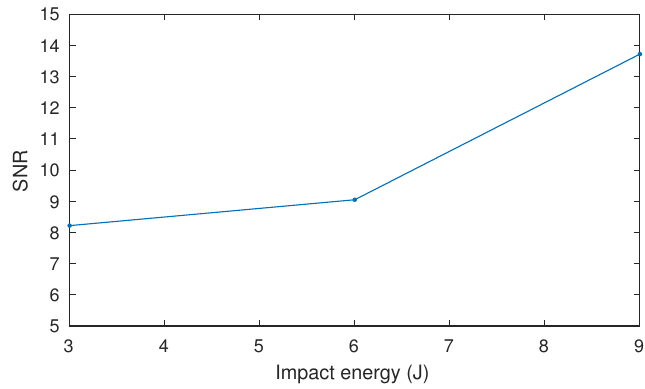
Figure 13. SNR for the there considered defects with impact energy of 3, 6 and 9J.